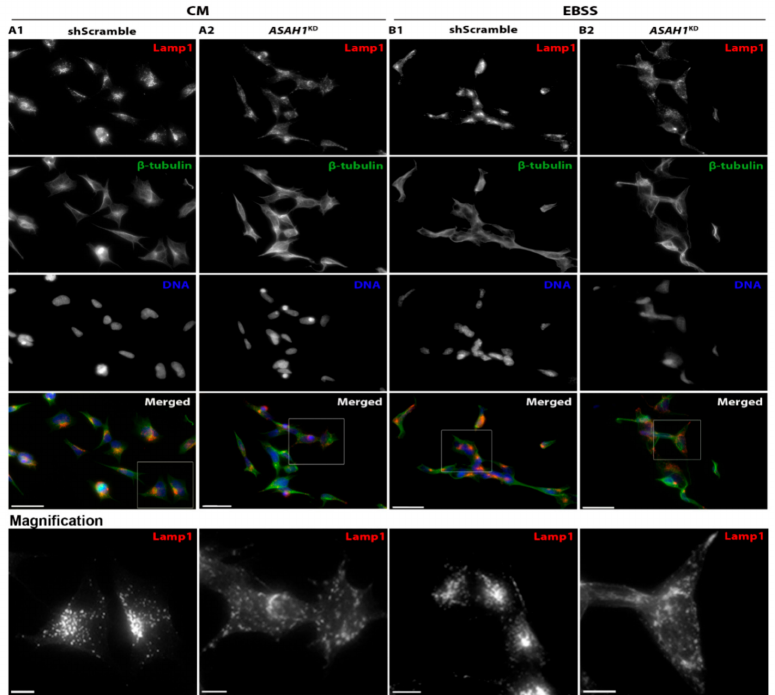
Figure 5. AC depletion alters the distribution of lysosomes. Immunofluorescence microscopy images of ( A1 ) shScramble cells show the normal distribution of lysosomes and ( A2 ) ASAH1 KD cells show a more di ff use pattern of lysosomes, under normal conditions (control medium, CM). ( B1 ) shScramble and ( B2 ) ASAH1 KD cells under starvation conditions (EBSS medium, for 2 h) show di ff erential lysosome distribution, with juxtanuclear location and continued di ff use distribution, respectively. Scale bars in merged images represent 40 µ m. For higher magnification images the scale bars represent 20 µ m. Lysosomes were stained with LAMP1 antibody (red in merged images), cytoskeleton with β -tubulin (green in merged images) and the nuclei with Hoechst dye (blue in merged images).